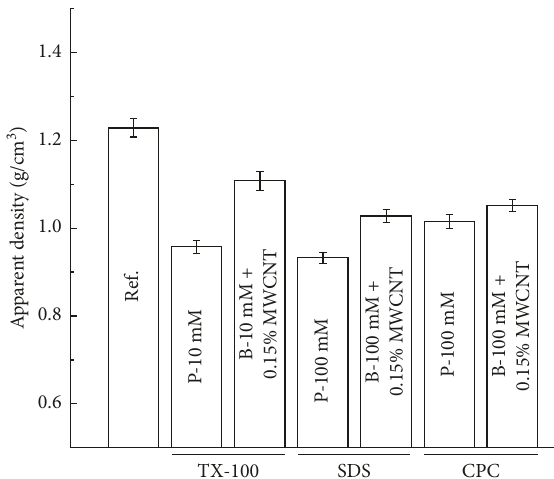
Figure 10: Apparent density of pastes tested in three-point bending.